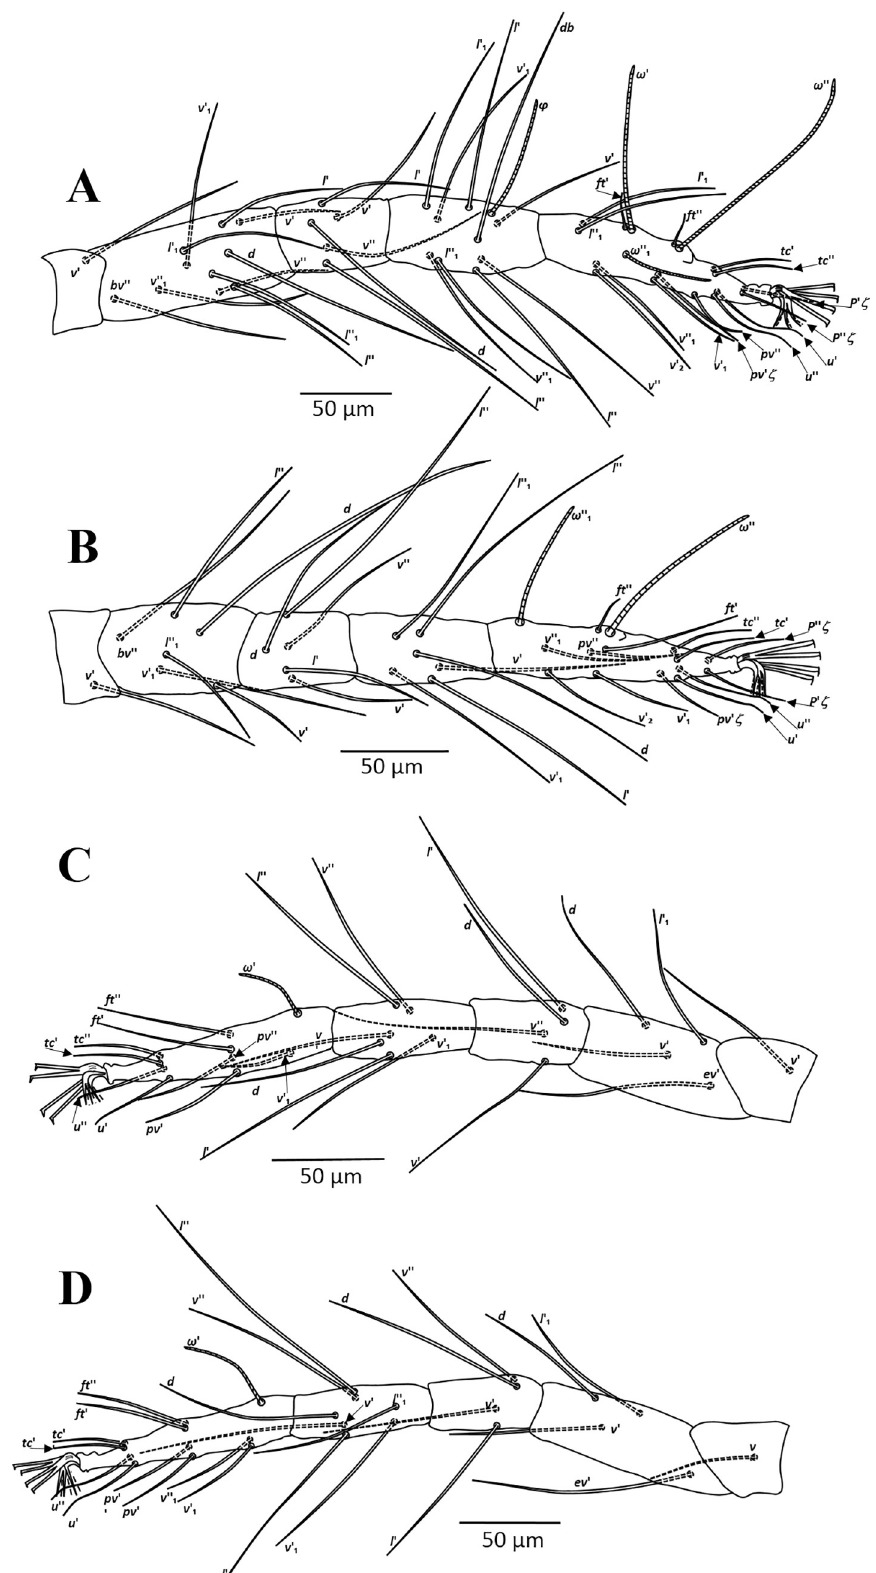
Fig 5. Amphitetranychus savenkoae , female—A. Leg I, B. Leg II, C. Leg III, D. Leg IV.